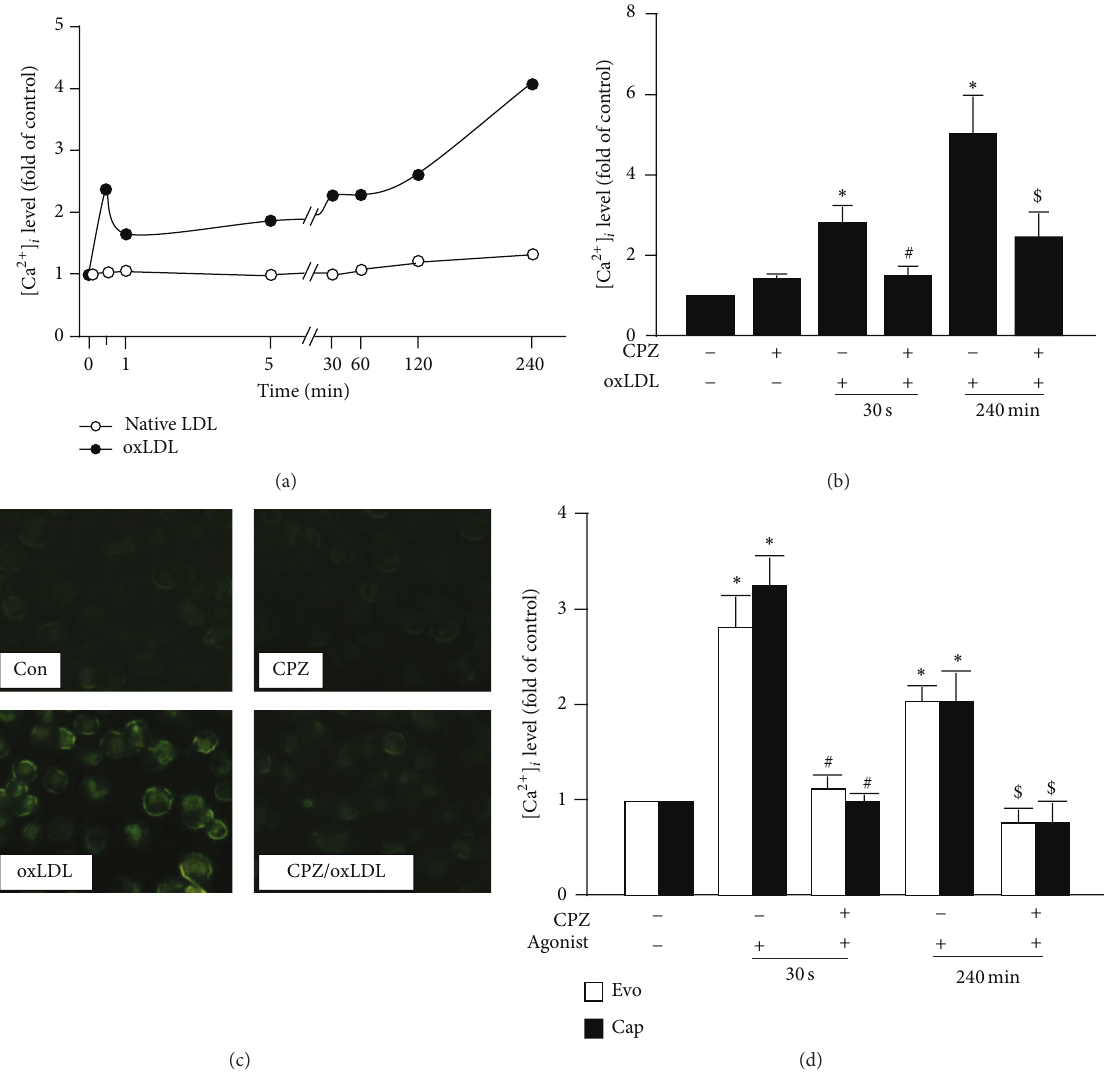
Figure 2: Treatment with oxLDL upregulates and activates TRPV1 in macrophages. (a) Intracellular levels of Ca 2+ ([Ca 2+ ] 𝑖 ) in response to incubation with oxLDL (50 𝜇 g/mL) or native LDL (50 𝜇 g/mL). [Ca 2+ ] 𝑖 was quantified by measuring the intensity of Ca 2+ -sensitive Fluo- 8 fluorescence. (b) [Ca 2+ ] 𝑖 level at 30 sec and 240min after incubation with oxLDL in BMDMs pretreated or not with capsazepine (CPZ; 10 𝜇 M). Data are mean ± SD from 5 independent experiments. ∗ 𝑃 < 0.05 versus vehicle, # 𝑃 < 0.05 versus 30 sec/oxLDL, and $ 𝑃 < 0.05 versus 240 min/oxLDL. (c) Representative microscopy images of Ca 2+ -binding Fluo-8 fluorescence at 240min after incubation with or without oxLDL in BMDMs pretreated or not with capsazepine. (d) [Ca 2+ ] 𝑖 level at 30sec and 240 min after incubation with evodiamine (Evo; 0.5 𝜇 M) or capsaicin (Cap; 10 𝜇 M) in BMDMs pretreated or not with capsazepine. Data are mean ± SD from 5 independent experiments. ∗ 𝑃 < 0.05 versus LDL-treated group or vehicle, # 𝑃 < 0.05 versus 30sec/Evo- or Cap-treated group, and $ 𝑃 < 0.05 versus 240 min/Evo- or Cap-treated